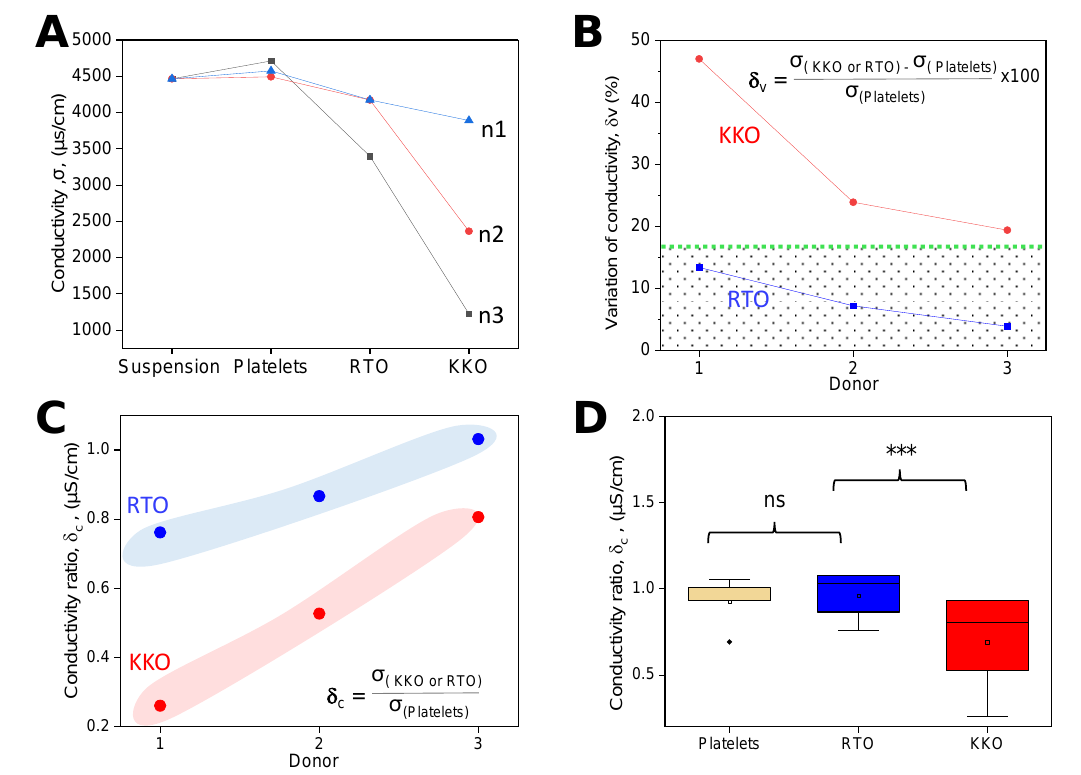
Figure 5. Platelet activation altered sample conductivity. ( A ) Platelet donors show the strongest reduction of conductivity caused by KKO, followed by RTO, whereas the platelet alone does not cause any change as compared with the buffer (n = 3). ( B ) Variation of conductivity ( δ v , inset) for (red) KKO is higher than that of the (blue) RTO boundary at ~17% (green). ( C ) Change in conductivity ( δ c , inset) from shows distinguishable σ c of (red) KKO from (blue) RTO. ( D ) Statistical comparisons (T-test) show a significant change of σ c between KKO and RTO, whereas no significant difference is obtained between the platelet alone and RTO (n = 5 repeats). ***: p <